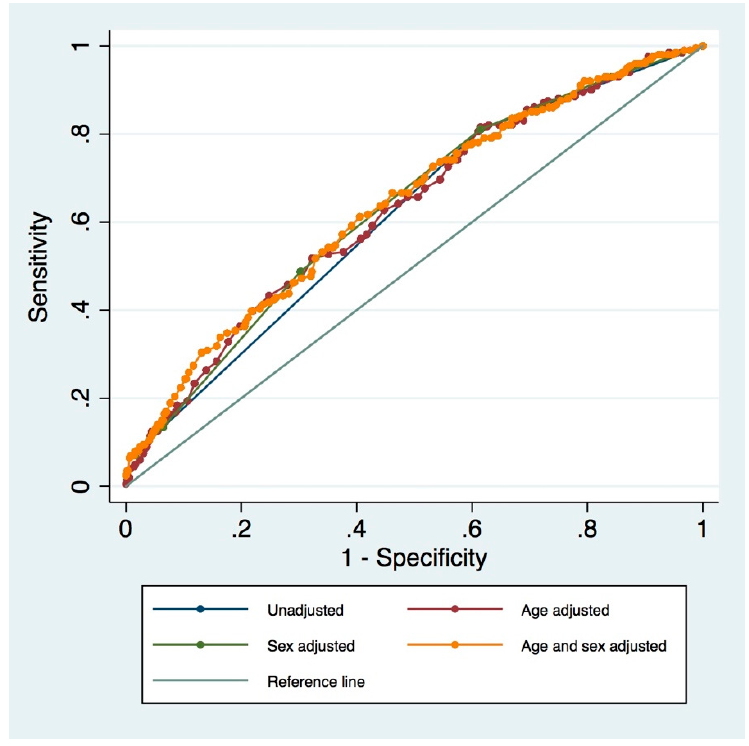
Figure 1. Unadjusted and adjusted ROC curves for original MPI and 12-month all-cause mortality. The diagnostic accuracy (area under the ROC curve) for the MPI adjusted for age and sex was 0.639 (95% CI: 0.593–0.684; Figure